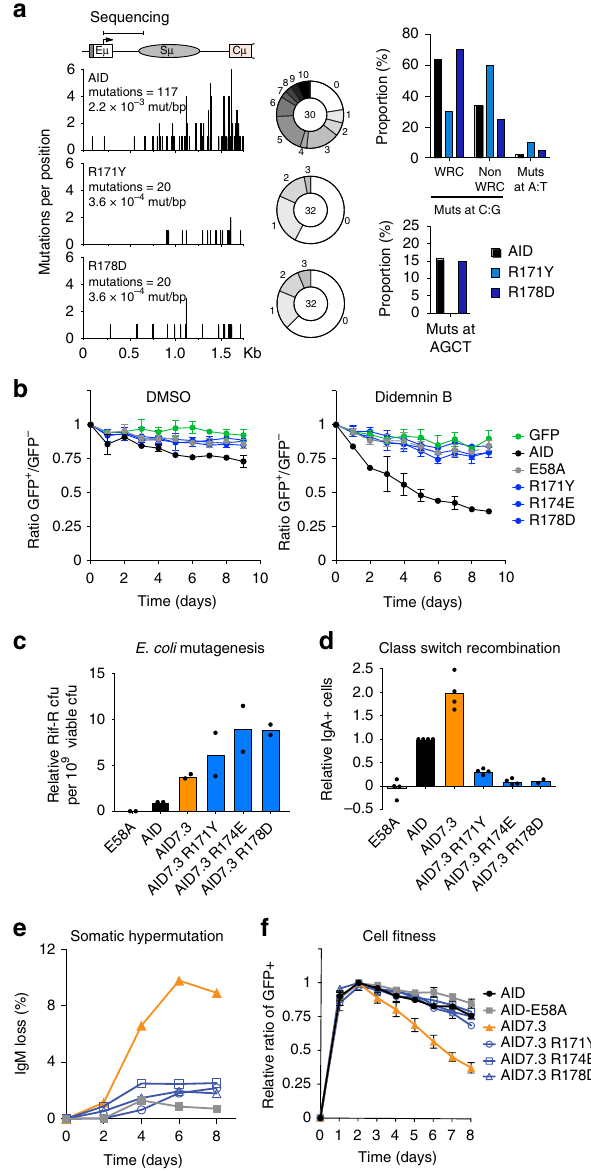
of AID7.3 variants in E. coli , measured by the relative frequency of rifampicin resistance (Rif-R). Means (bars) of median values (dots) from